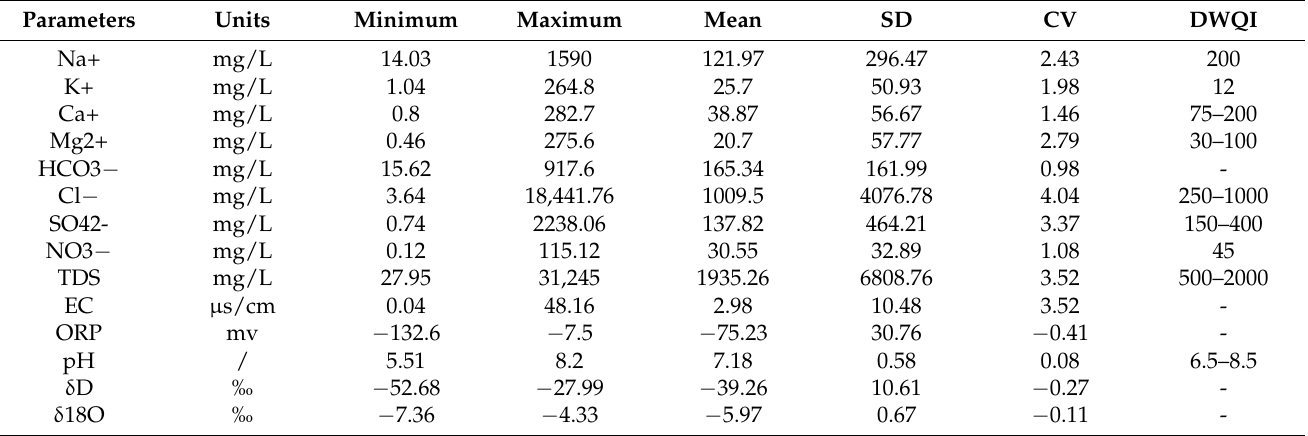
Table 2. Statistical characteristics of the major chemical composition of groundwater in